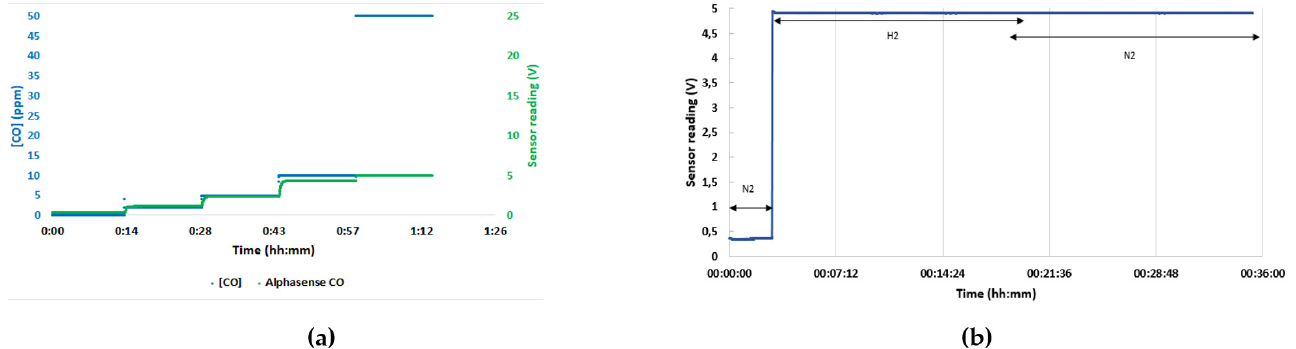
Figure 3. project [45]. With this rig, several sensors mounted in parallel can be tested simultaneous Figure 3. Results of sensor testing at Air Liquide facility ( a ) CO measurements in nitrogen, resulting under varying compositions and at different flow rates, as shown in Figure 4. in an expected response from the sensor, and ( b ) pure hydrogen, overload.